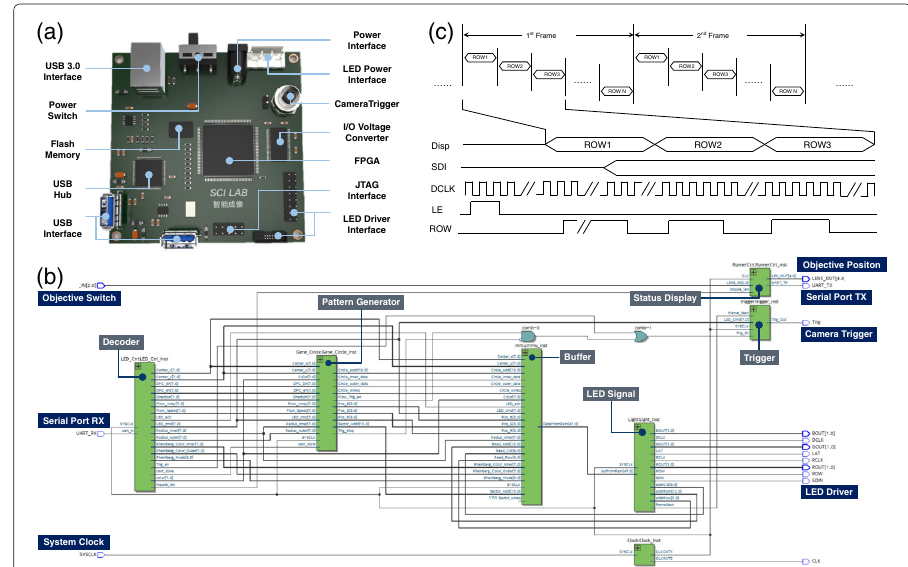
Fig. 34 The control unit for SCLMs. (a) The components of the control unit PCB. (b) The resistor